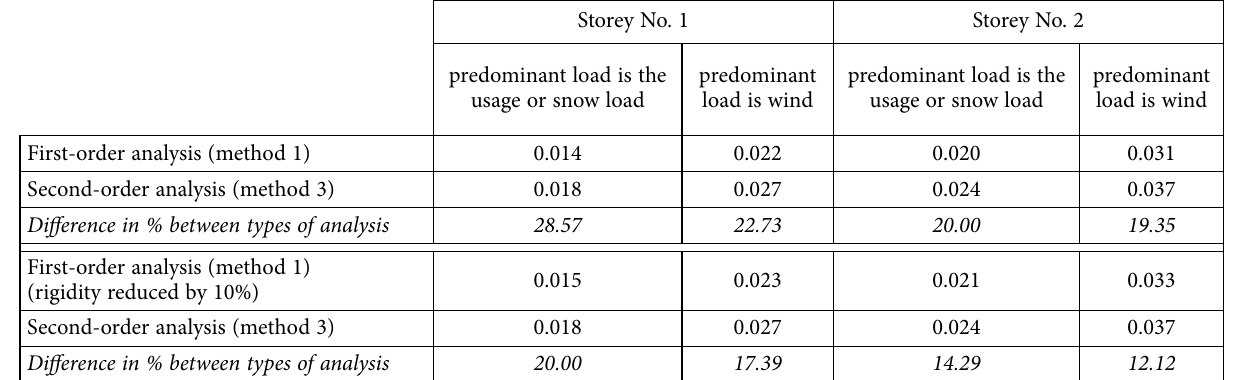
Table 3. Results of frame deformations calculated by metods 1 and 3 Storey No. 1 Storey No.